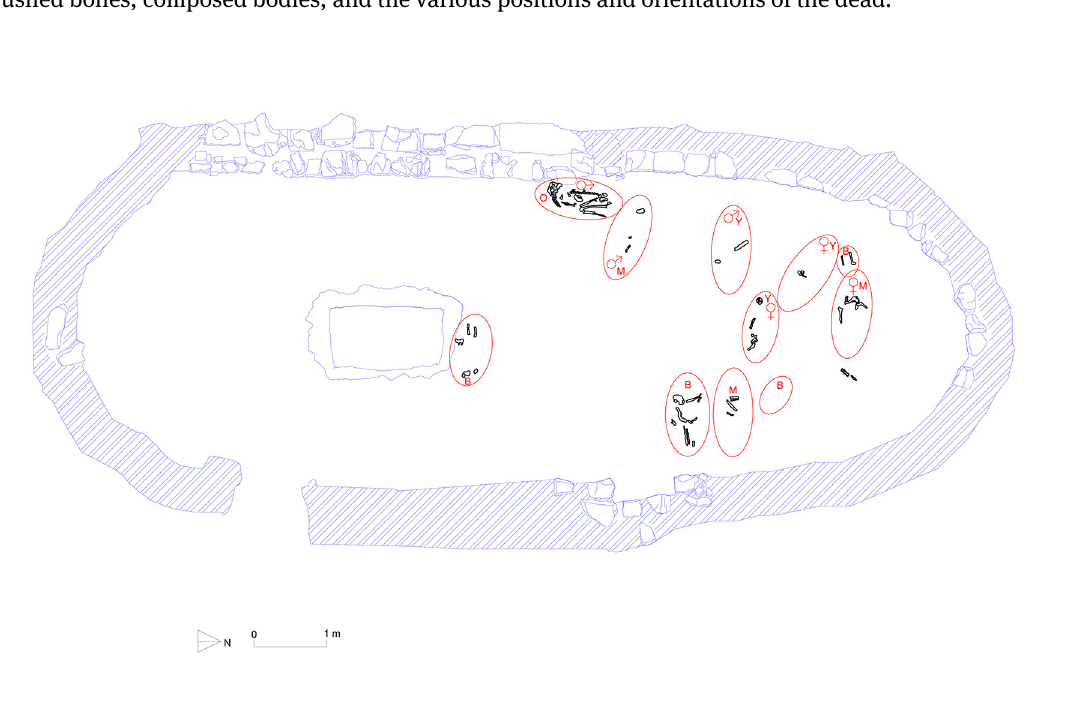
Figure 5. Calicantone. Distribution of the best-preserved skeletons. When possible, the gender and the age (B: Baby <